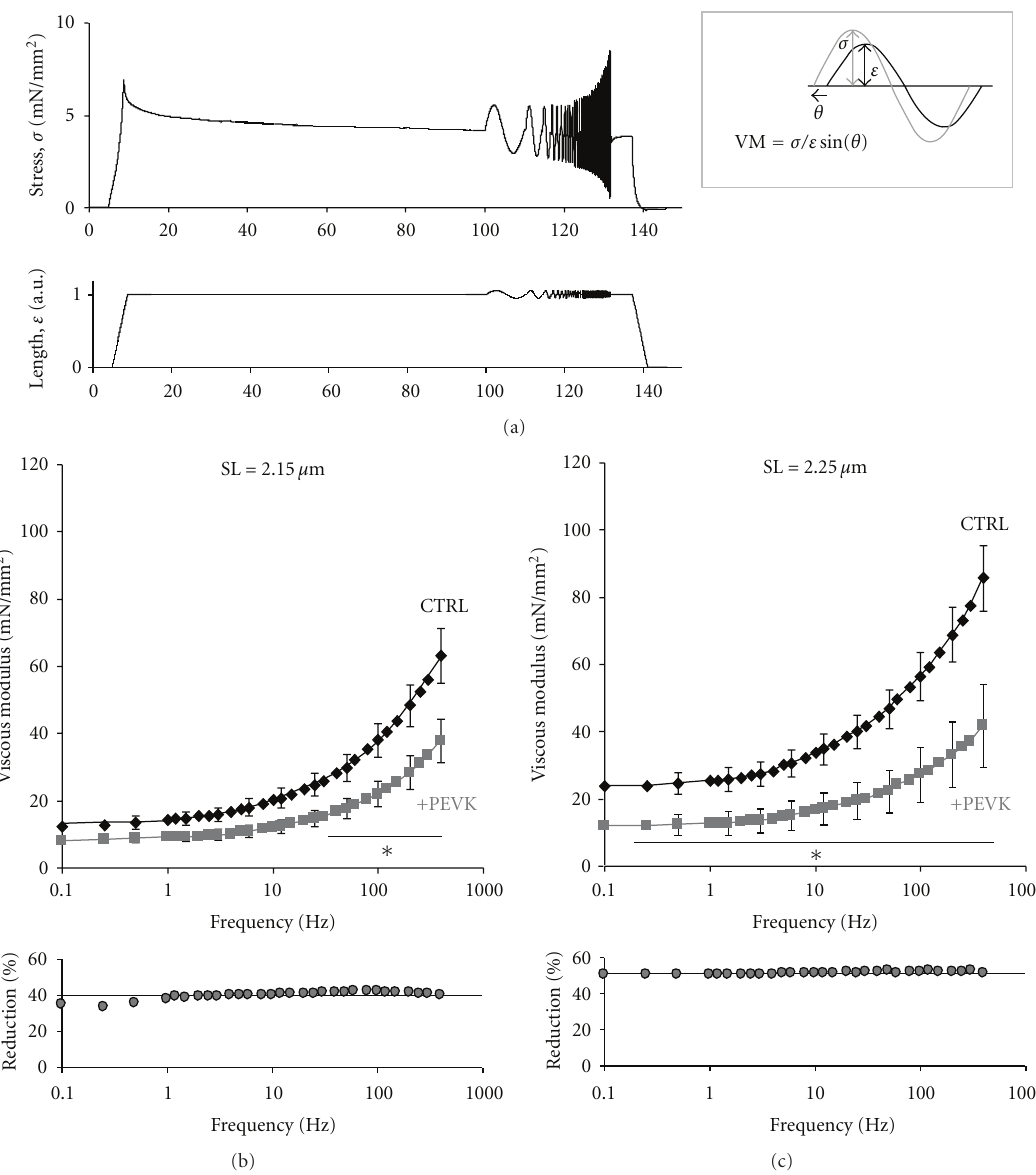
Figure 3: Measurement of viscous moduli via sinusoidal analysis in pig tissue. (a) The frequency sweep perturbation is imparted after a 90-second hold at SL of 2.15 or 2.25 μ m. The viscous modulus is calculated utilizing the magnitude of the stress response, magnitude of the length perturbation and phase delay (schematic, right). (b) The viscous modulus measured in control tissues at SL of 2.15 μ m (CTRL, black) is reduced in the presence of recombinant PEVK proteins (+PEVK, gray) by 40%. (c) At a SL of 2.25 μ m, adding PEVK protein (+PEVK, gray) reduces the viscous modulus at all frequencies. ∗ indicates P < 0 . 05 across the frequencies noted by the horizontal bar. See text for